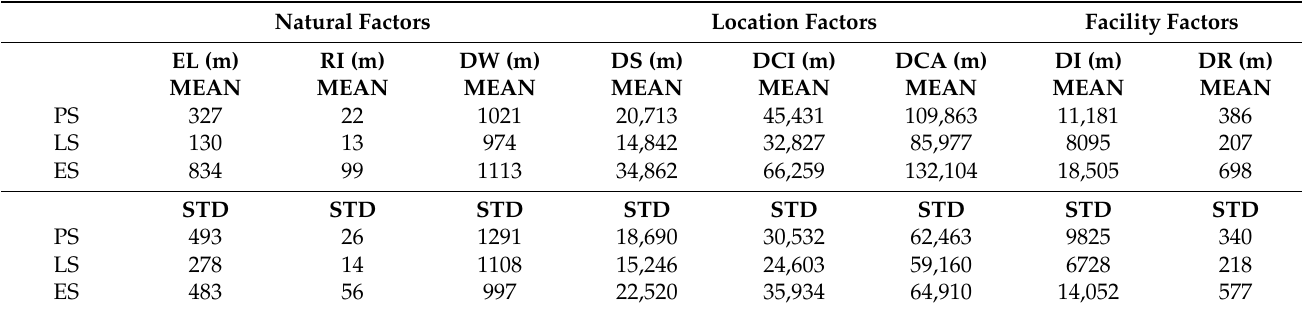
Natural Factors Location